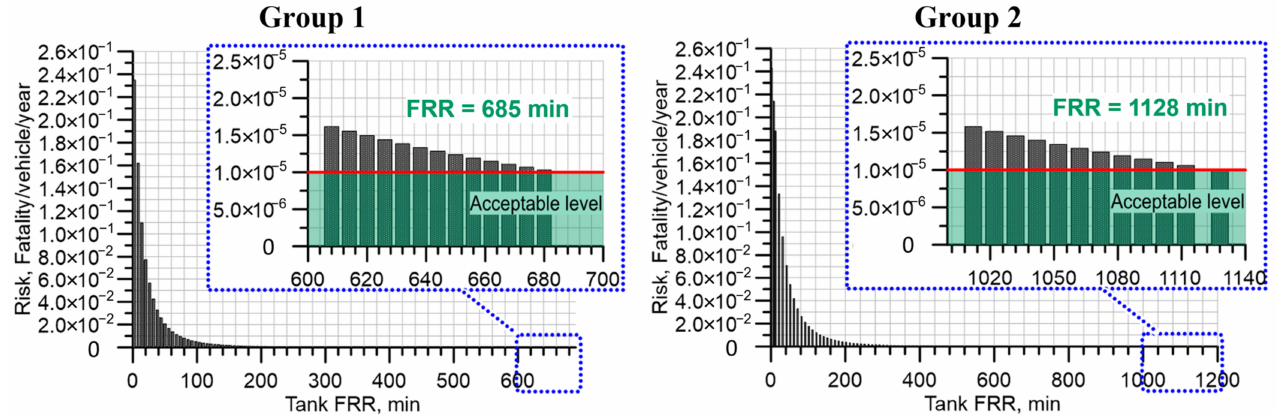
Figure 9. Risk (fatality/vehicle/year) as a function of hydrogen storage tank FRR for 62.4 L tank rupture at SoC = 59% due to localised fire: Group 1 ( left ) and Group 2 ( right